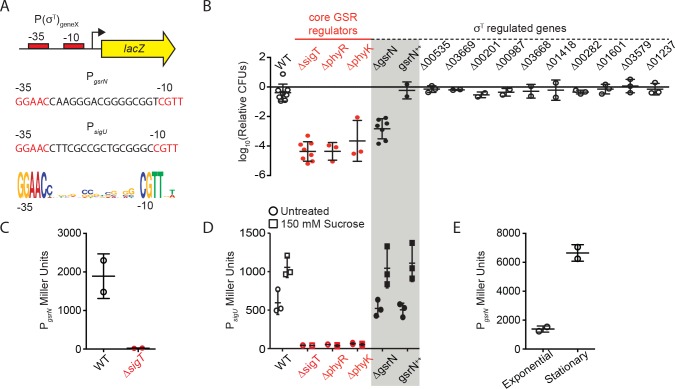
gsrN transcription is activated by σT and induced in stationary phase growth.GsrN does not affect transcription from a σT-dependent reporter. (A) Schematic of lacZ transcriptional fusions to the promoters of gsrN and sigU. sigU is a well-characterized reporter of GSR transcription (Foreman et al., 2012). Promoters of both genes contain a consensus σT binding site (nucleotides in red) (Alvarez-Martinez et al., 2007; McGrath et al., 2007; Staroń et al., 2009). σT binding motif (bottom) generated from 21 σT-dependent promoters using WebLogo (Crooks et al., 2004). (B) Quantification of relative hydrogen peroxide survival of strains presented in Figure 1E. CFU of peroxide treated cultures were normalized by the CFU of the paired untreated culture. Genotypes are indicated above each bar. Numbers indicate CCNA locus numbers of deleted genes. gsrN++ is the 4gsrN overexpression strain described in Figure 2A and Figure 2—figure supplement 1A. Bars represent mean ± SD from at least two independent biological replicates (points). (C) β-galactosidase activity from the PgsrNlacZ transcriptional fusion in Caulobacter wild-type and ΔsigT backgrounds measured in Miller Units. Bars represent mean ±SD from two independent cultures. (D) β-galactosidase activity from the PsigUlacZ transcriptional fusion in a sub-set of the genetic backgrounds in (B). GSR transcription was induced by exposure to 150 mM sucrose (final concentration) for three hours before measuring β-galactosidase activity. Exposure time and sucrose concentration were chosen based on past experiments with this reporter (Foreman et al., 2012). Bars represent mean ±SD from three independent cultures. (E) β-galactosidase activity from the PgsrNlacZ transcriptional fusion in exponentially growing (OD660≈ 0.25) and early stationary phase (OD660≈ 0.75) wild-type cells. This result is consistent with cultures grown to a range of early to late stationary phase densities (OD660 ≈ 0.7–1.2; data not show). Bars represent mean ±SD from two independent cultures.